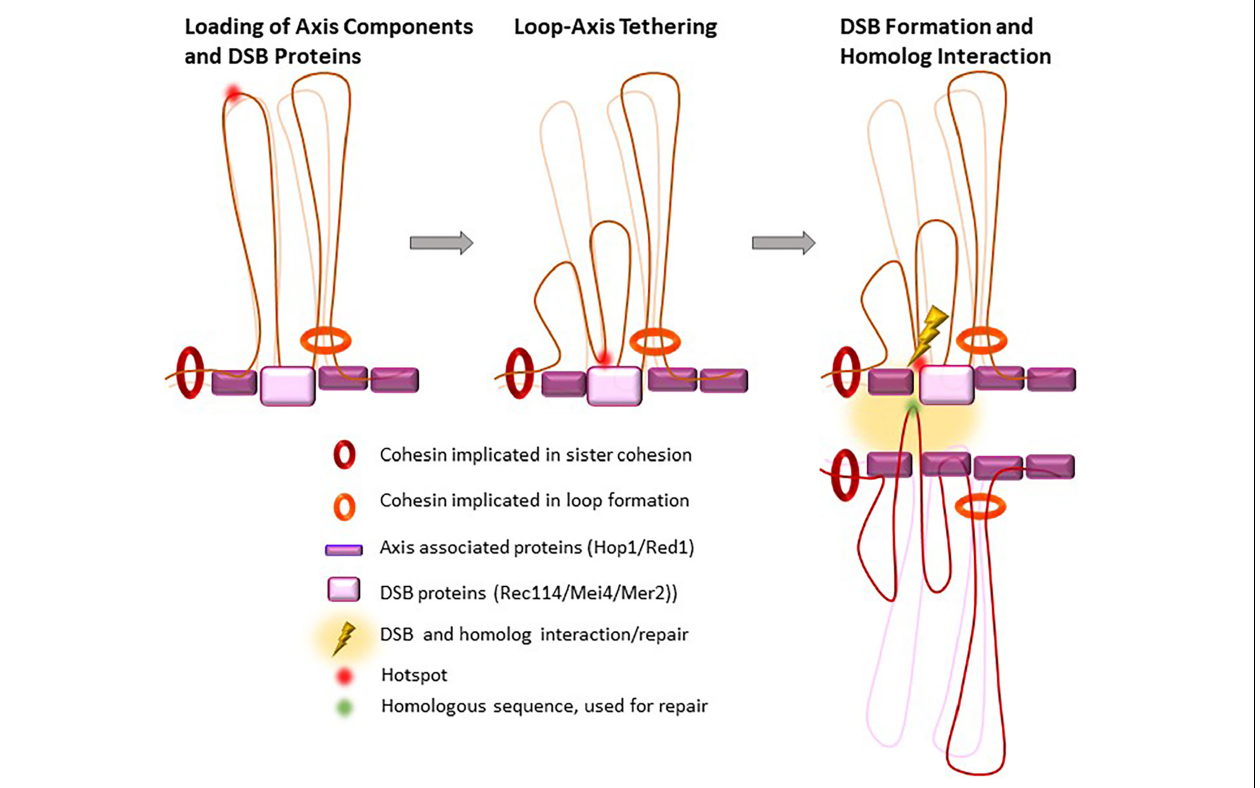
FIGURE 4 | Proposed loop re-organization at leptonema upon and after DSB formation. In early prophase I, meiotic hotspots localize in loops and the DSB formation proteins (DSB pre-recombinosome) localize on the axis. Before DSB formation, hotspots contact the DSB pre-recombinosome, reorganizing the loops that contain hotspots where DSB will